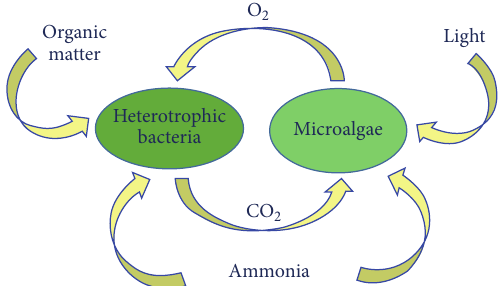
Figure 3: Interactions of a mix culture containing heterotrophic bacteria and